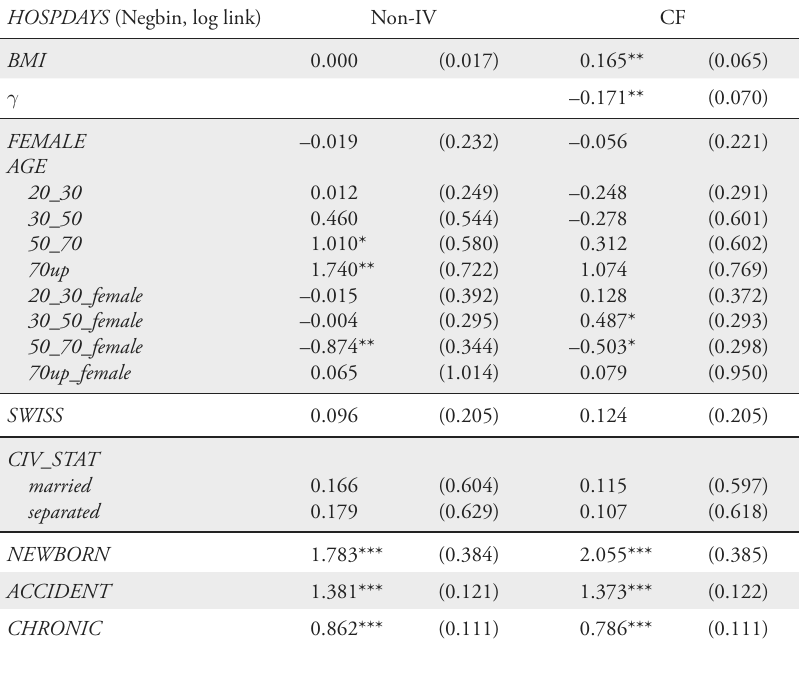
Table 10: Complete Output from the Inpatient